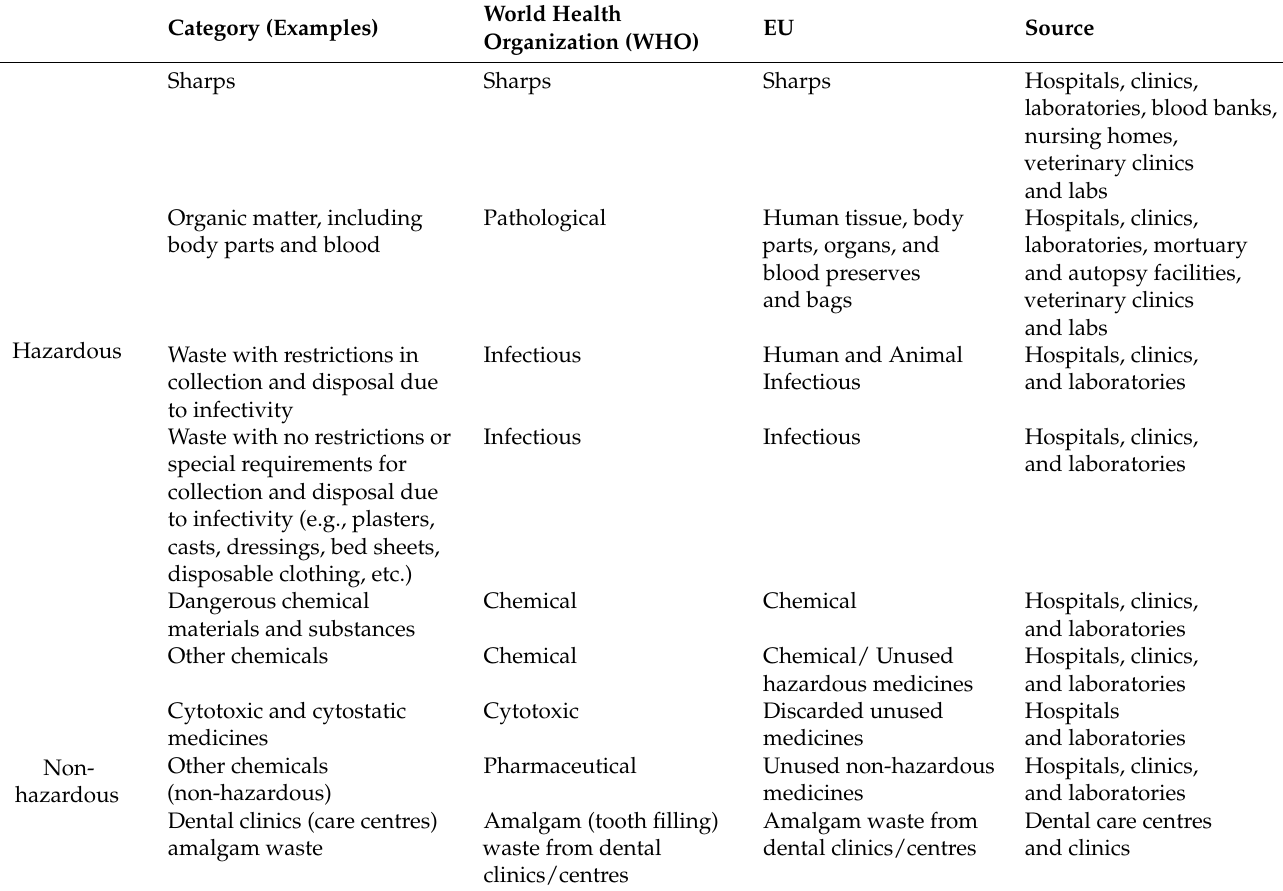
Figure 1. Different types of hazardous medical waste. Table 1. Healthcare waste categorisation according to WHO and the EU